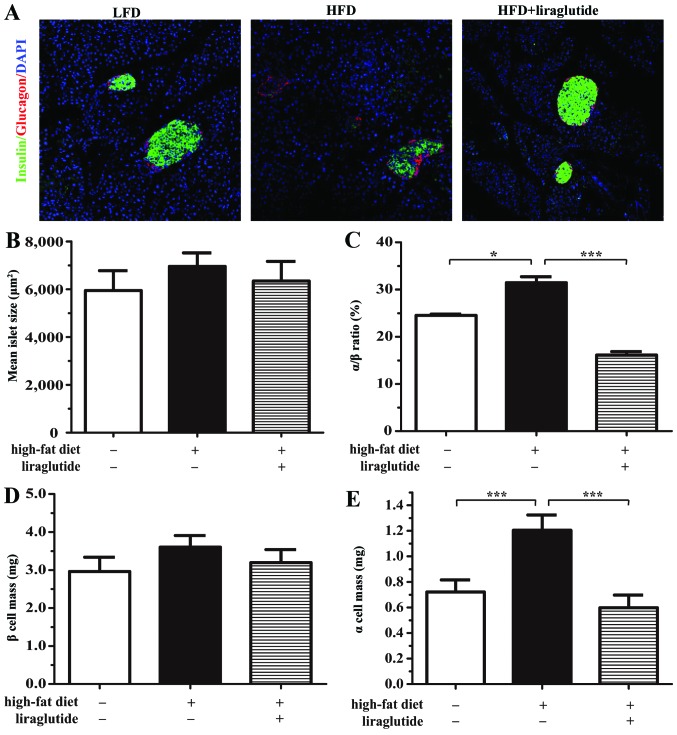
Liraglutide normalizes the islet architecture of mice fed a high-fat diet (HFD). (A) Representative images of staining for insulin (green) and glucagon (red). After immunofluorescence, areas labeled for insulin (β-cell) and glucagon (red) were measured, and the results are expressed as the mean (B) islet size, (C) α/β ratio, (D) β cell mass and (E) α cell mass. Analyses were performed on histological sections obtained from mice fed a low-fat diet (LFD) + the placebo (phosphate-buffered saline) (LFD; n=6), a HFD + placebo (phosphate-buffered saline) (HFD; n=7) or a HFD + liraglutide (n=6). *p<0.05; ***p<0.001.